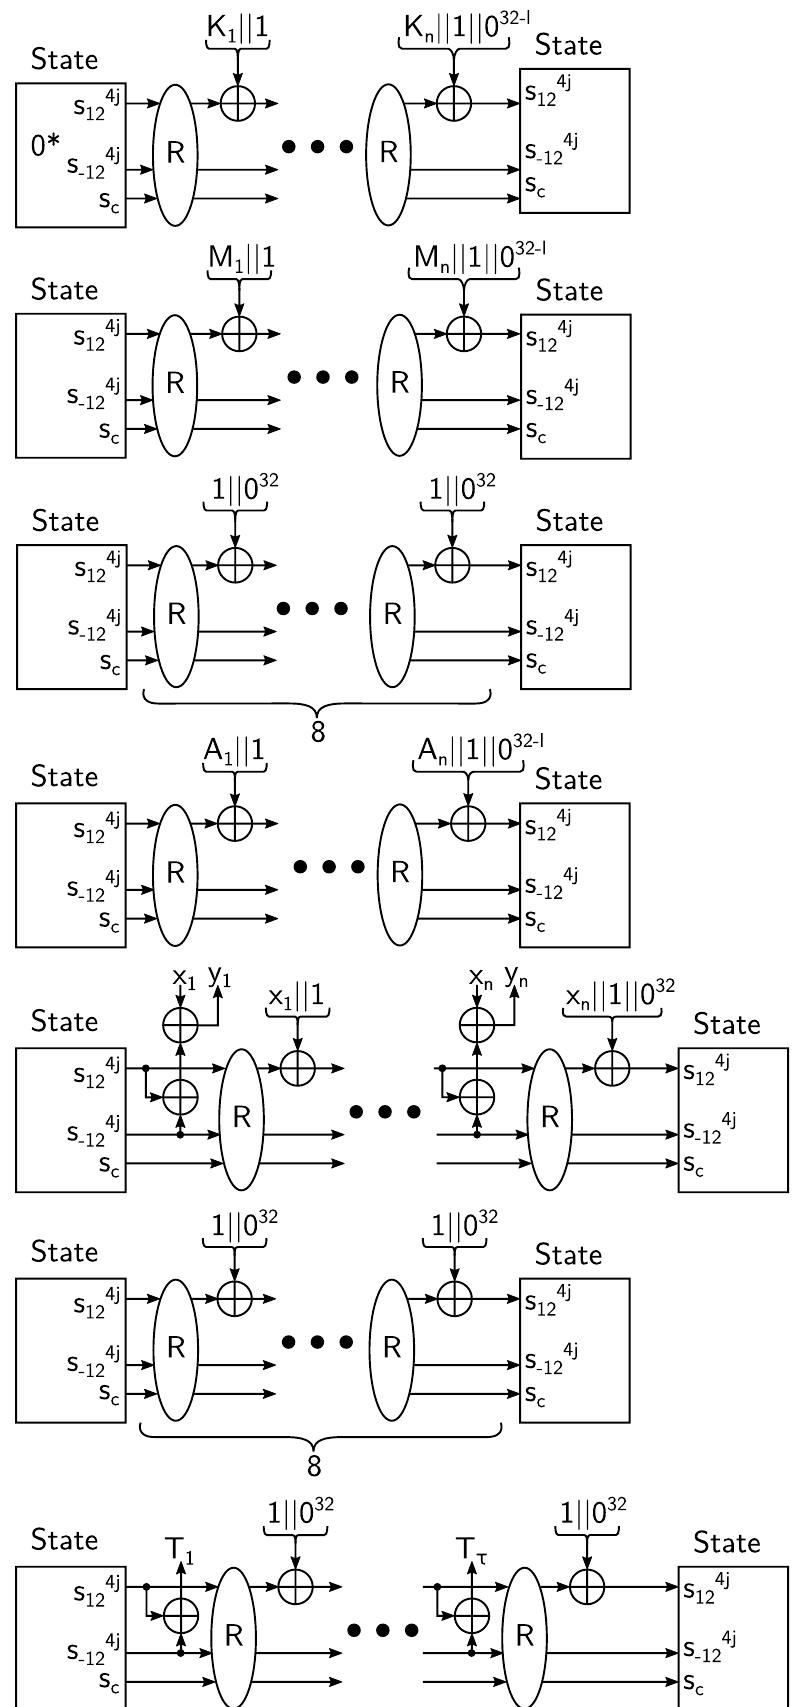
Figure 13: Subterranean-SAE, only encryption is